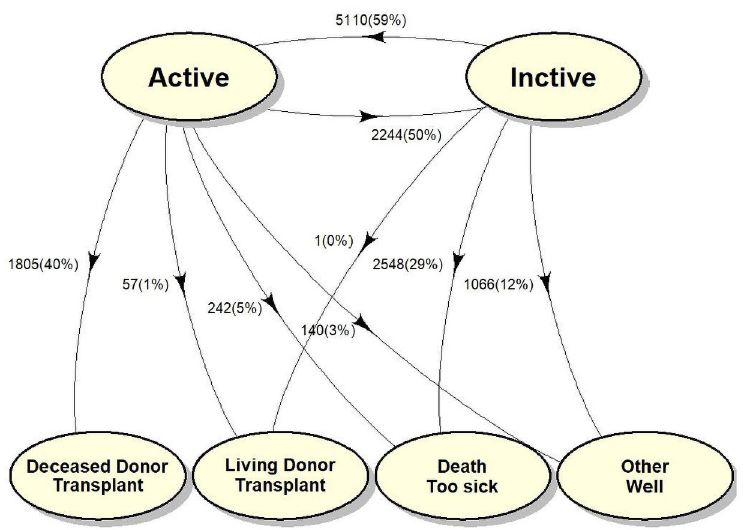
Fig 1. Multistate model schematic of transitions with competing risks outcomes. Inactive patients have no direct path to transplant. However, the inactive to active status transition allows the calculation of waitlist outcomes from active status. Frequencies and percentages of each transition provided next to each